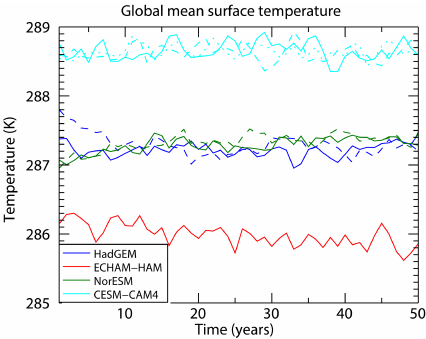
Figure 3. Time evolution of global mean annual average surface temperature in the control simulations. Solid lines show the mem- ber 1 control simulation for each model and, where present, dashed lines show member 2 and dotted lines show member